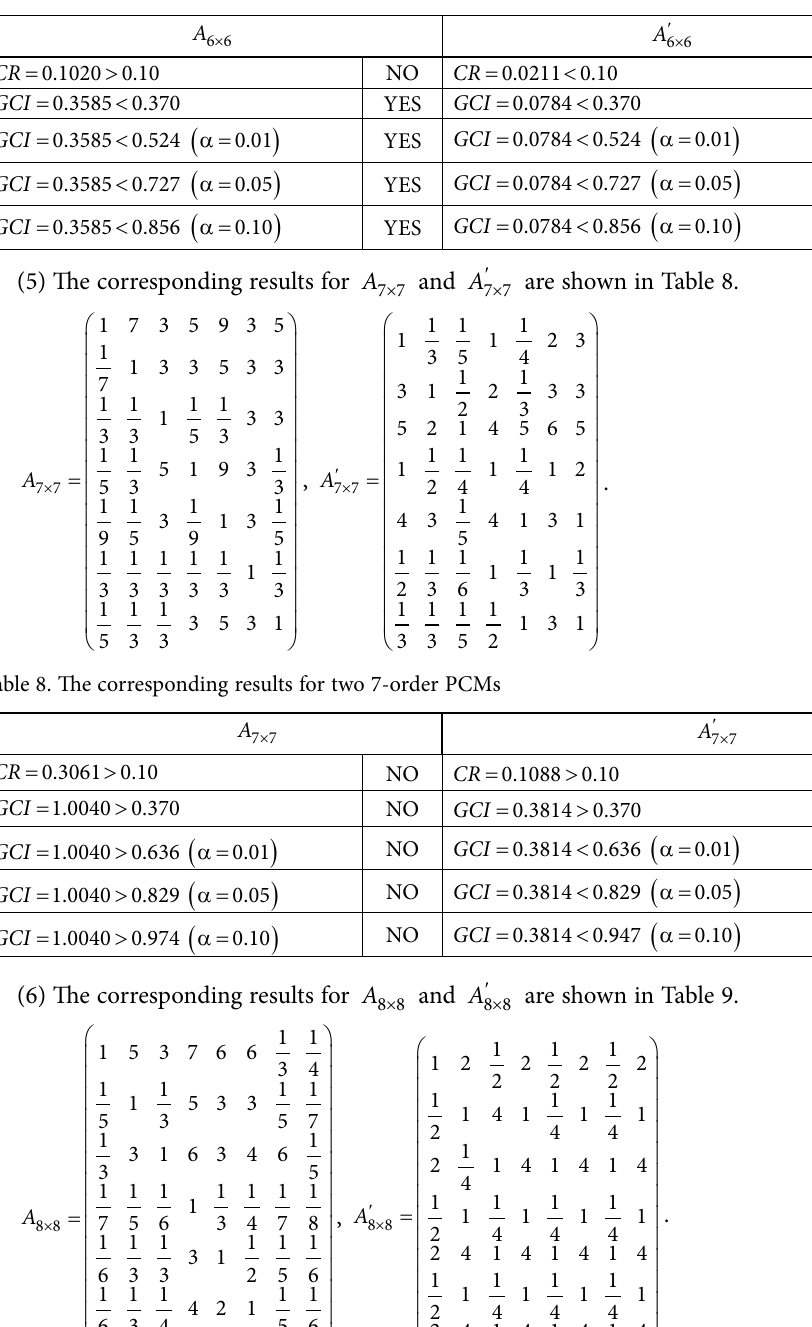
Table 7. The corresponding results for two 6-order PCMs